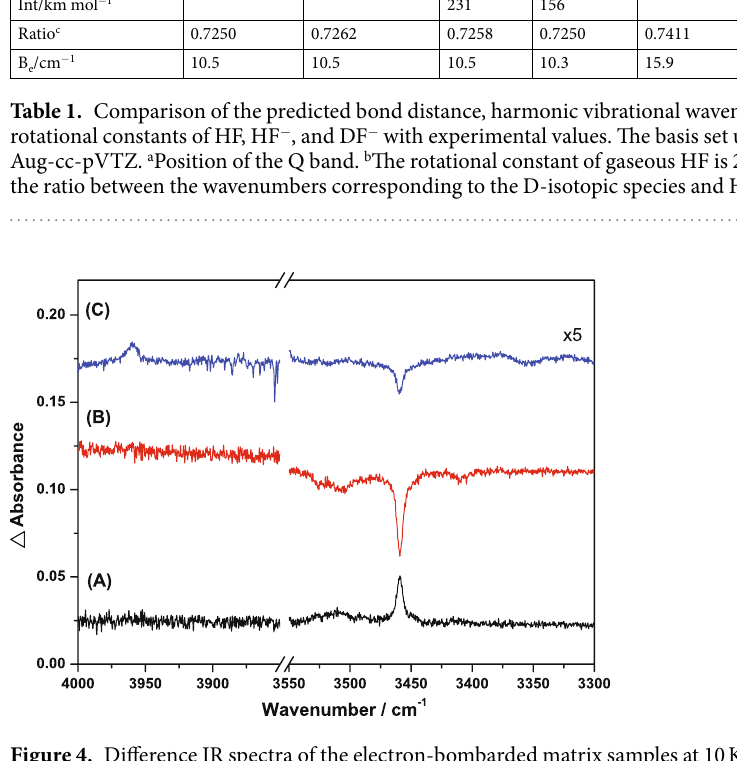
Figure 4. Difference IR spectra of the electron-bombarded matrix samples at 10 K upon secondary photolysis with ( A ) 210 nm and ( B ) 385 nm, and ( C ) maintained in the dark for 4